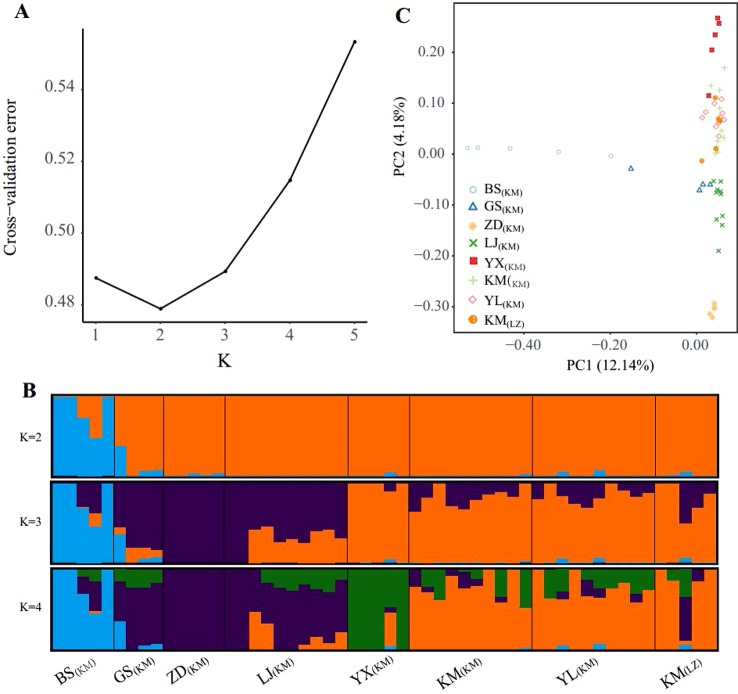
Population structure of the sampled individuals based on full SNP dataset. (A) Plot of Cross-validation (CV) error, (B) Genetic assignments under K = 2 – 4 based on ADMIXTURE results, (C) Plot of the two principal components and the percentage of variance explained resulting from a principal component analysis.